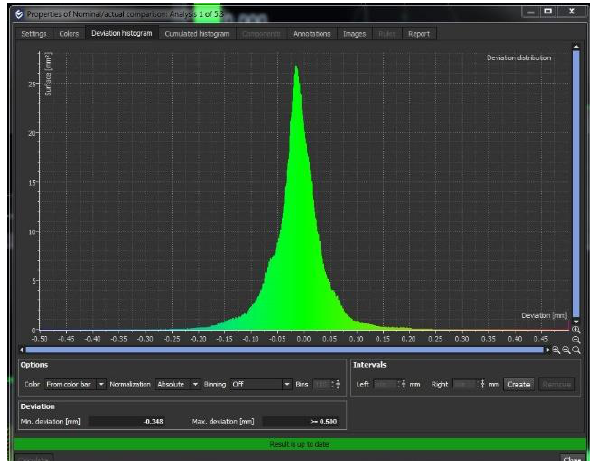
Figure 12. Volumetric deviation from CAD model on test plate No. 5.3. Good approximation of Gaussian distribution, centred around zero, indicates that there are no systematic errors in the production process.